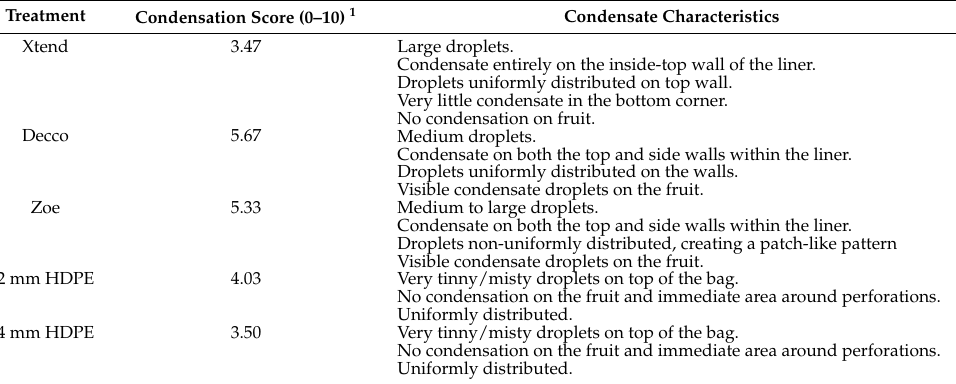
Table 2. Condensate characterisation inside plastic liner bags for pomegranate fruit stored at 5 ◦ C and 90% relative humidity (RH). HDPE: high density